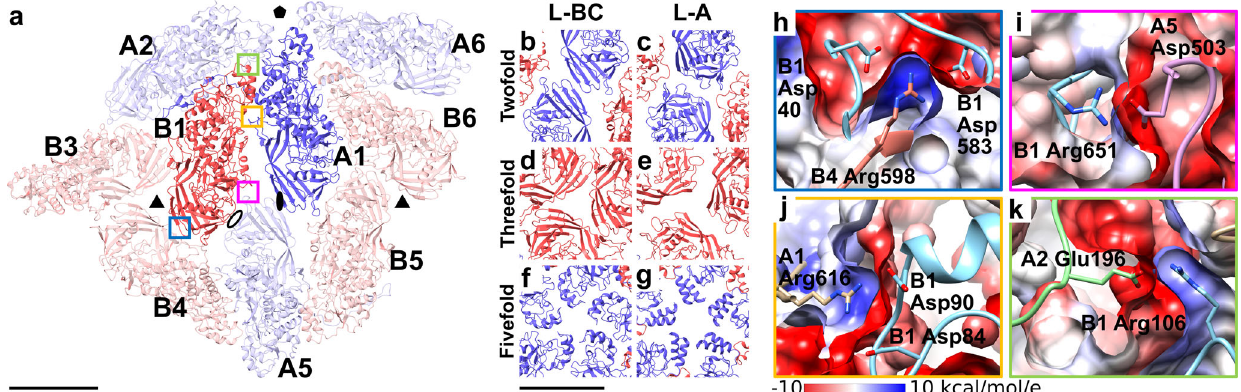
Fig. 4 Inter-subunit interactions in L-BC capsid. a Cartoon representation of L-BC capsid proteins forming an icosahedral asymmetric unit (bright colors) with all their interaction partners within the capsid (pale colors). View from outside the capsid. Scale bar 50 Å. A subunits are shown in blue and B subunits are shown in red. Subunits belonging to different icosahedral units are indicated with numbers. Positions of selected icosahedral symmetry axes are indicated: twofold - oval, threefold - triangle, fi vefold - pentagon, and quasi-twofold - empty oval. b – g Comparisons of intersubunit contacts around icosahedral symmetry axes of L-BC and L-A viruses. The coloring scheme is the same as in a . Scale bar 50 Å. h – k Details of interactions between capsid proteins of L-BC. The color of the frame of each panel corresponds to that of boxed areas in a . The capsid proteins are shown in cartoon representation with side chains of selected residues depicted in stick-representation. The side chains are colored according to the atom type: oxygen in red and nitrogen in blue. Molecular surfaces colored according to electrostatic potential are shown to demonstrate the compatibility of interacting